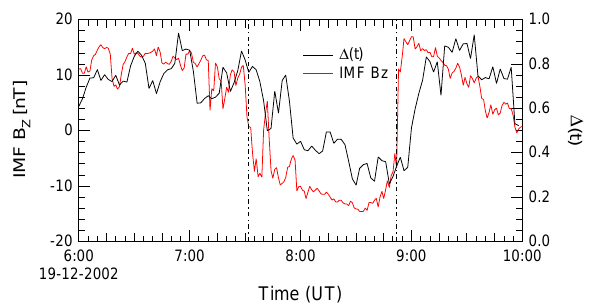
Fig. 4. Time series of IMF B z (red, axis on the left) in GSM coordinates, and normalised disorder degree Δ( t ) (black, axis on the right) for the December 19th, 2002, 06:00 – 10:00 UT interval. The vertical black dashed lines indicates the times when B z changes of sign, from positive to negative and vice versa.